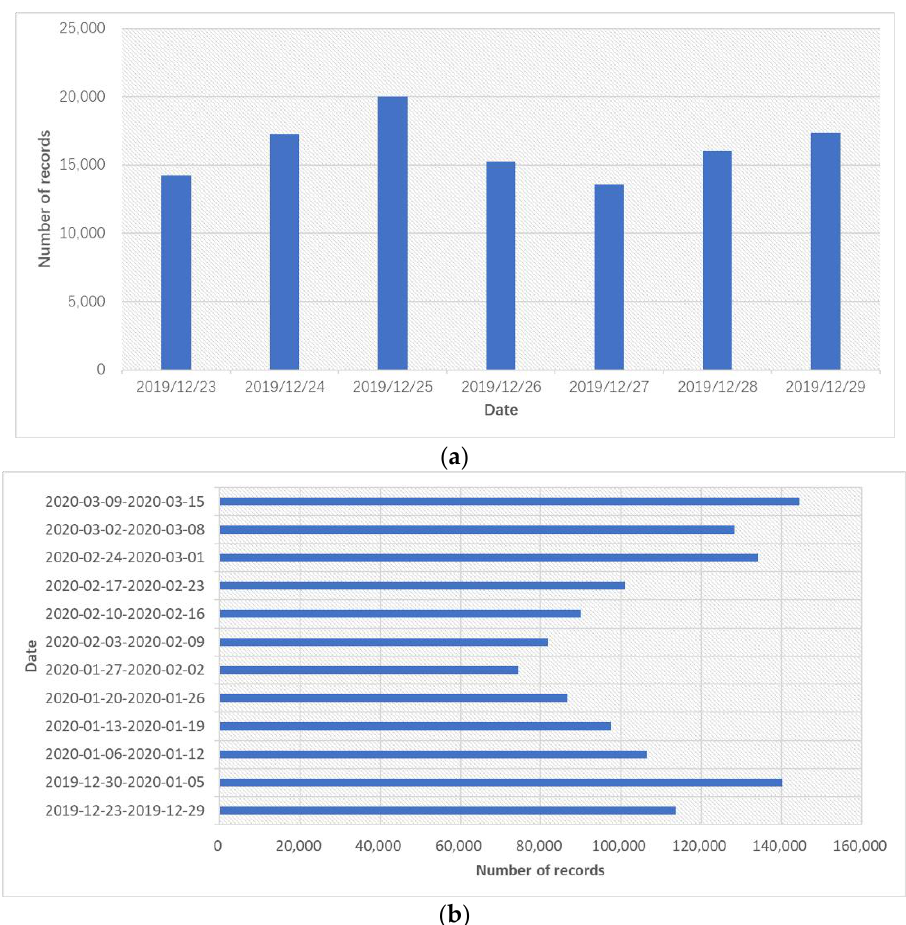
Figure 2. Statistical chart of data volume on different dates: ( a ) 7 days extracted from the first week in the GBA dataset; ( b ) the whole 12 weeks in the GBA dataset.